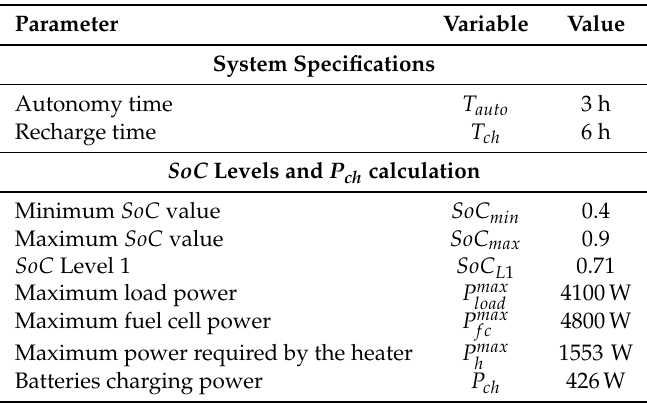
Table 6. Real system specifications and EMS